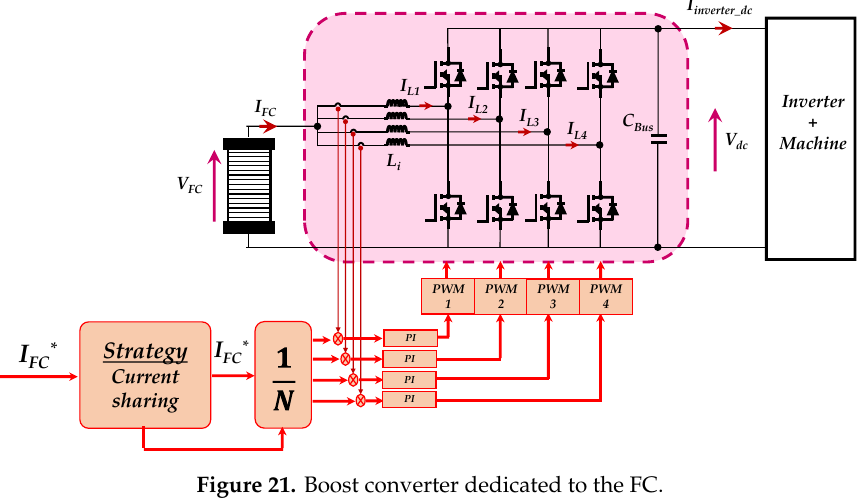
Figure 21. Boost converter dedicated to the FC. Energies 2020 , 13 , x FOR PEER REVIEW